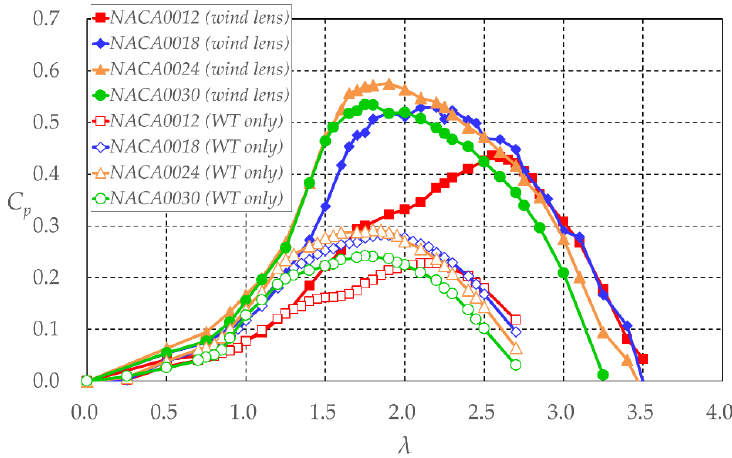
Figure 14. Power coefficient C p of wind turbines with airfoils of various thickness with and without a wind lens vs. tip speed ratio λ (wind lens: L = 1.14 D m, h = 0.5 D m, φ = 15°). Refer to Figure 2 for L , D , h , and φ.